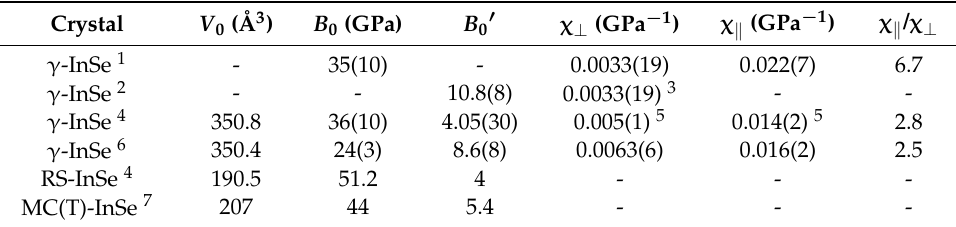
Table 1. Equation of state parameters and compressibility tensor for InSe crystal